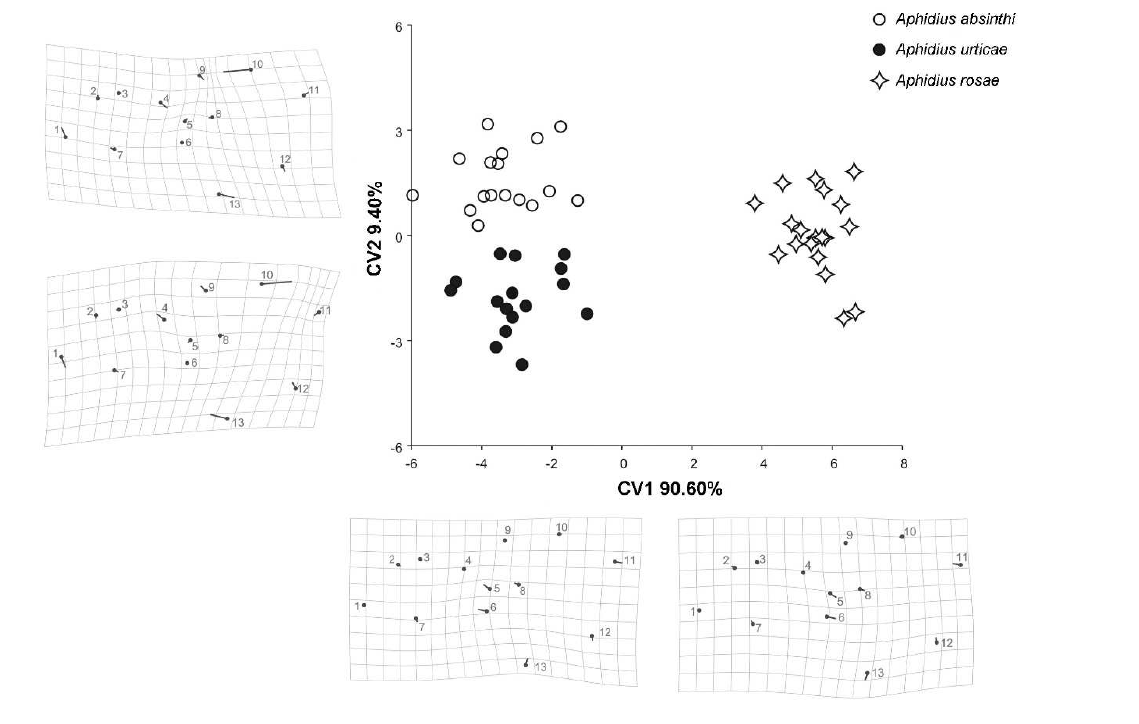
Fig. 3. Ordination of the Aphidius specimens in the morpho-space. The thin-plate spline deformation grids illustrate the wing shape changes correlated with the first and the second canonical